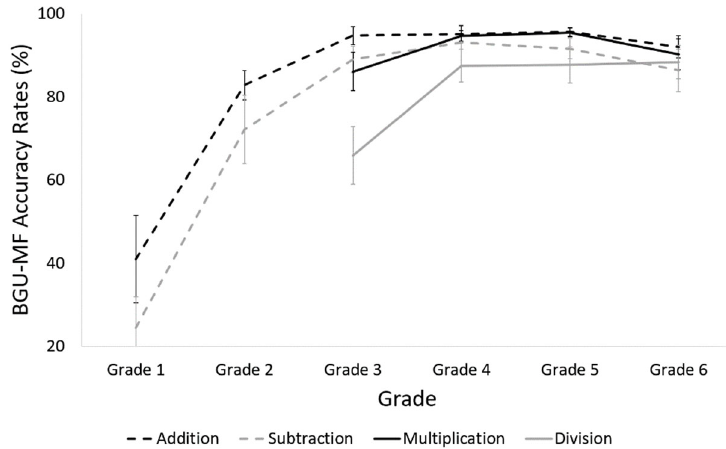
Figure 8. Accuracy rates in the BGU ‐ MF, of every operation, in each